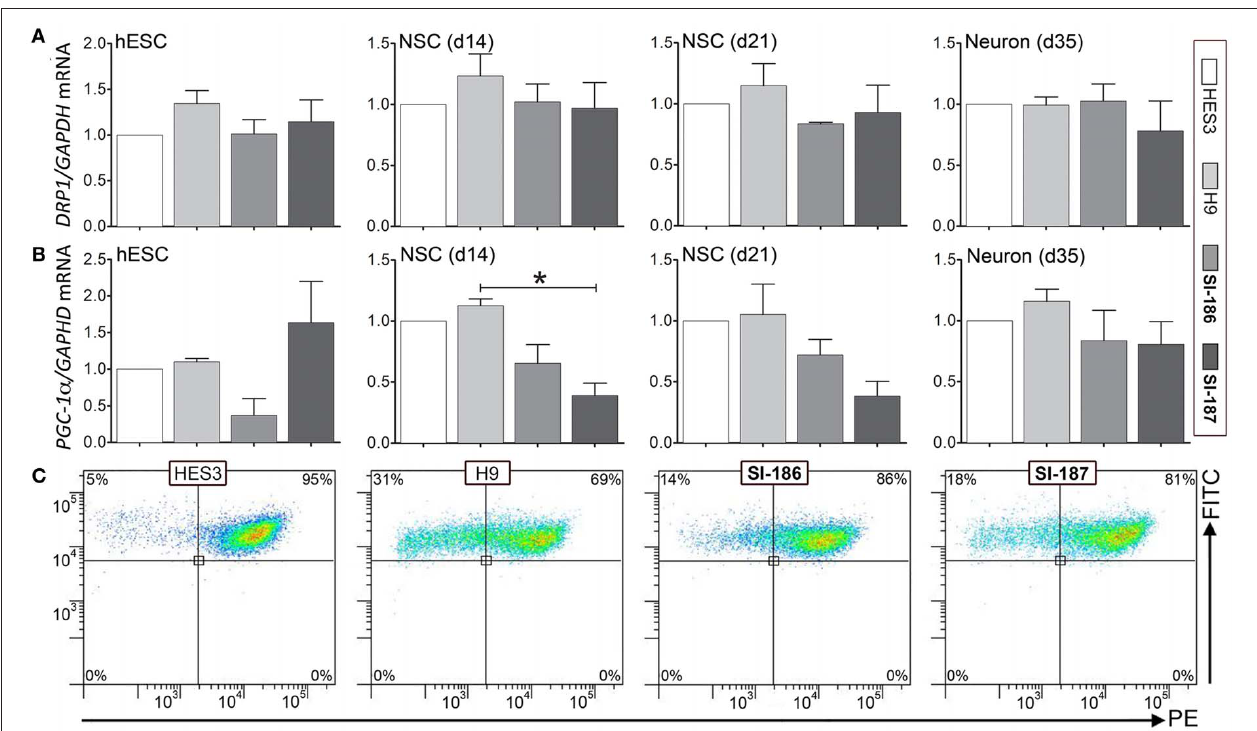
FIGURE 7 | Assessment of mitochondrial gene expression and function. Relative transcript quantification for all four lines are normalized to the control HES3 line for mitochondrial genes (A) DRP1 and (B) PGC-1 α at the undifferentiated (d0), neurosphere (d14) and